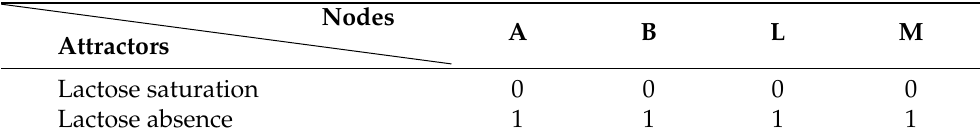
Table 6. Relationship between attractors and environmental scenarios in the lac operon. There is one attractor per scenario and every row conveys an